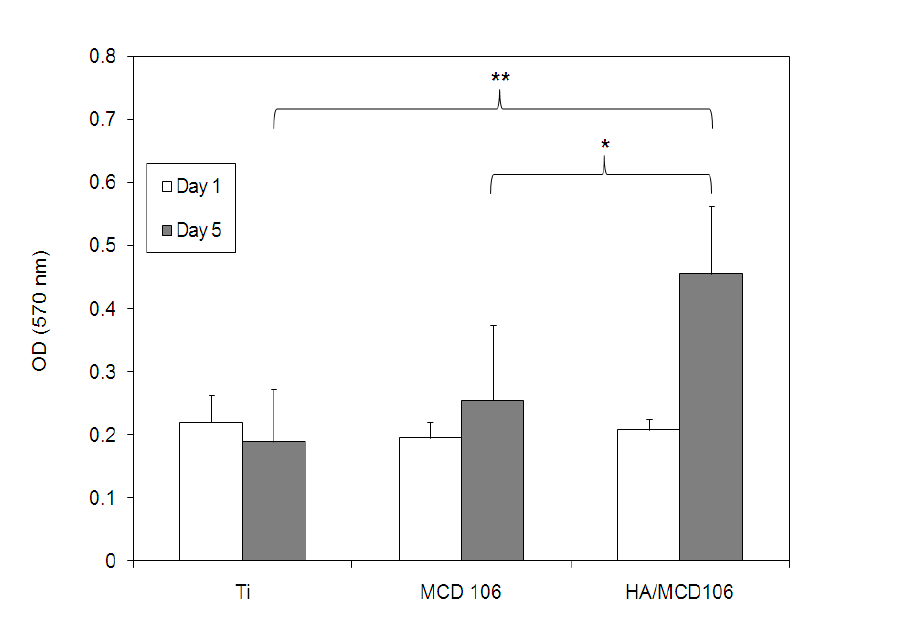
Figure 7. (3-(4,5-dimethylthiazol-2-yl)-2,5-diphenyltetrazolium bromide) (MTT) assay data